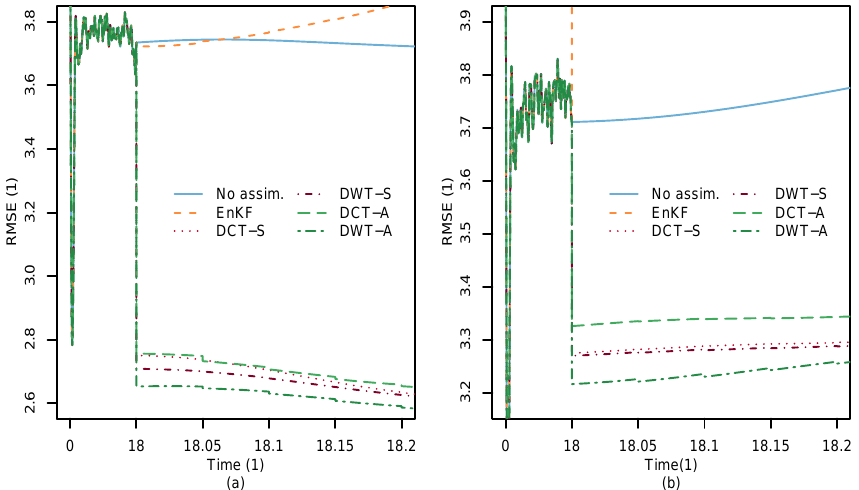
Figure 3. Mean RMSE from 10 realizations for the Lorenz 96 problem, ensemble size 16, state dimension 256. (a) First 128 points observed and (b) first 64 points observed.